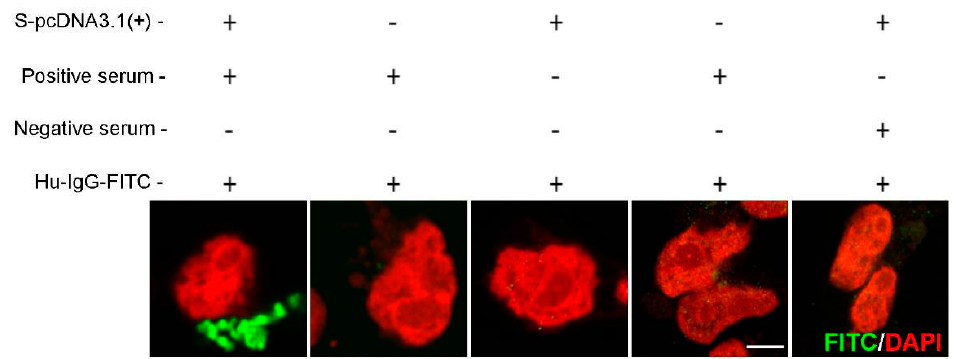
Figure 3. Specificity of spike/anti-SARS-CoV-2 IgG labelling. FITC signals in naive or SARS-CoV-2-spike cells treated with COVID-19-positive or negative serum. Images were analysed using a confocal Airyscan microscopy. FITC: green; cell nuclei: red. Scale bar: 10 µm.